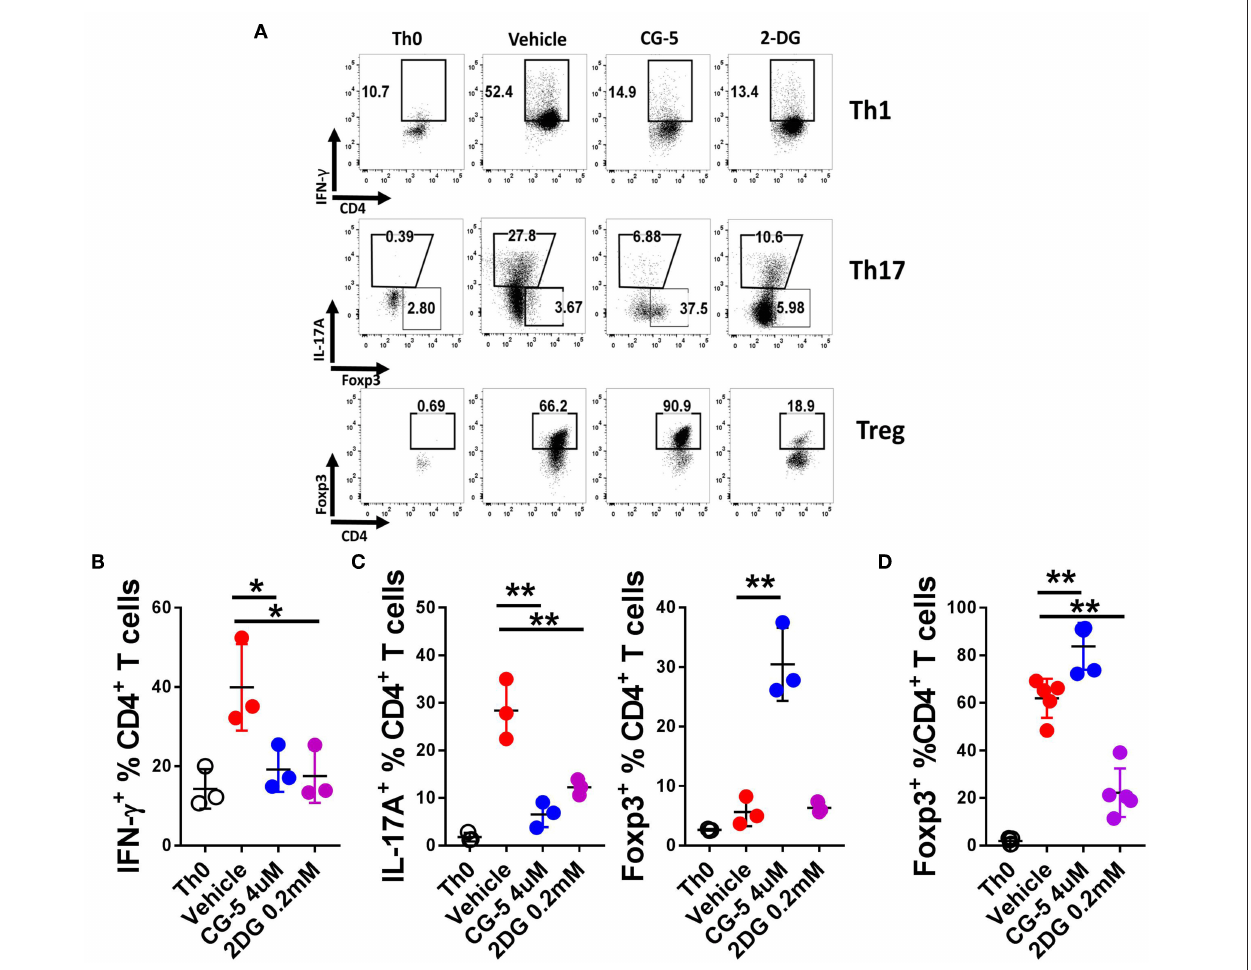
FIGURE 3 | CG-5 inhibits Th1 and Th17 while promoting Treg differentiation in vitro . CD4 + T cells from B6 mice were cultured under polarizing conditions in the presence of vehicle, CG-5, or 2DG for 5 days. (A) Representative FACS plots of live CD4 + -gated cells stained with IFN- γ (Th1), IL-17A and Foxp3 (Th17), and Foxp3 (Treg). Th0 conditions only contain antiCD3/CD28 mAbs. Frequency of IFN- γ + CD4 + T cells under Th1 conditions (B) , IL-17A + CD4 + and Foxp3 + CD4 + under Th17 conditions (C) , and Foxp3 + CD4 + under Treg conditions (D) . Mean ± S.E.M of n = 3–5 per group compared with the vehicle-treated group using one-way ANOVA. * p < 0.05; ** p <